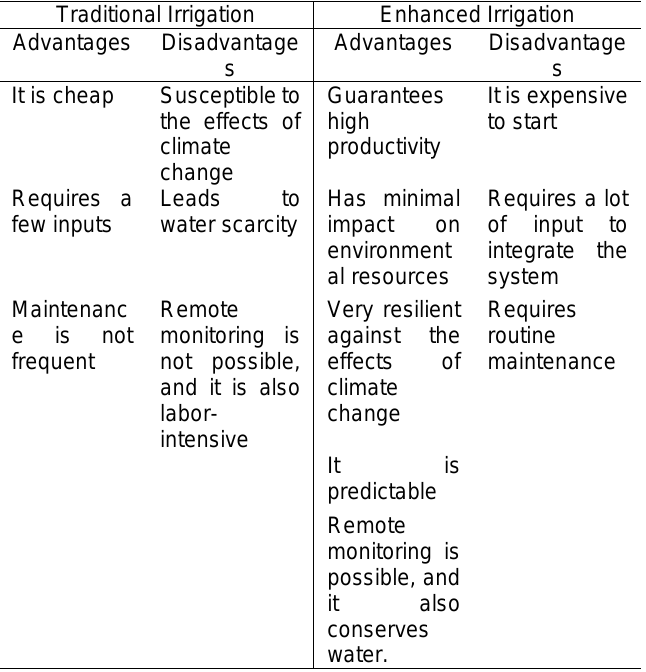
Table 3. Comparison between traditional irrigation and enhanced irrigation in terms of advantages and